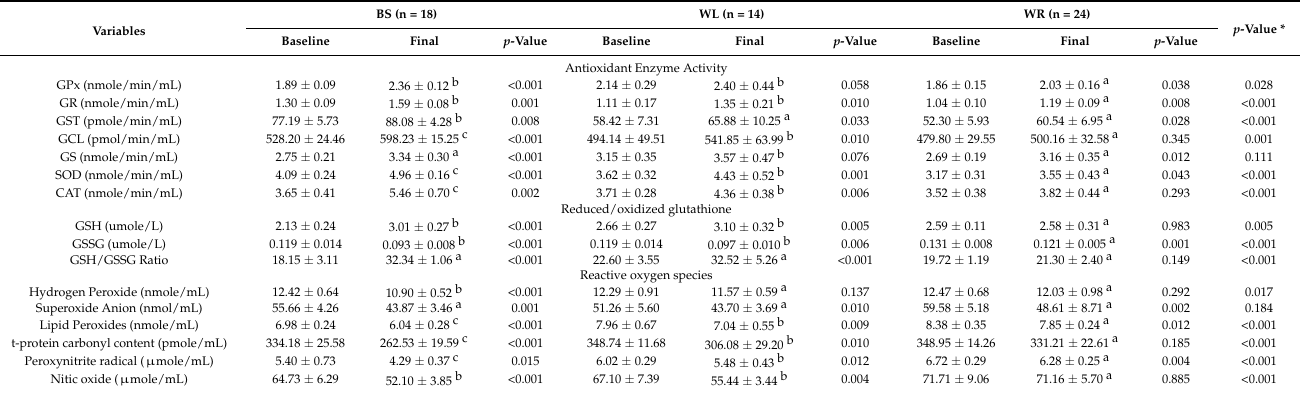
Table 4. Changes in antioxidant enzyme activities and oxidative stress parameters among study groups.